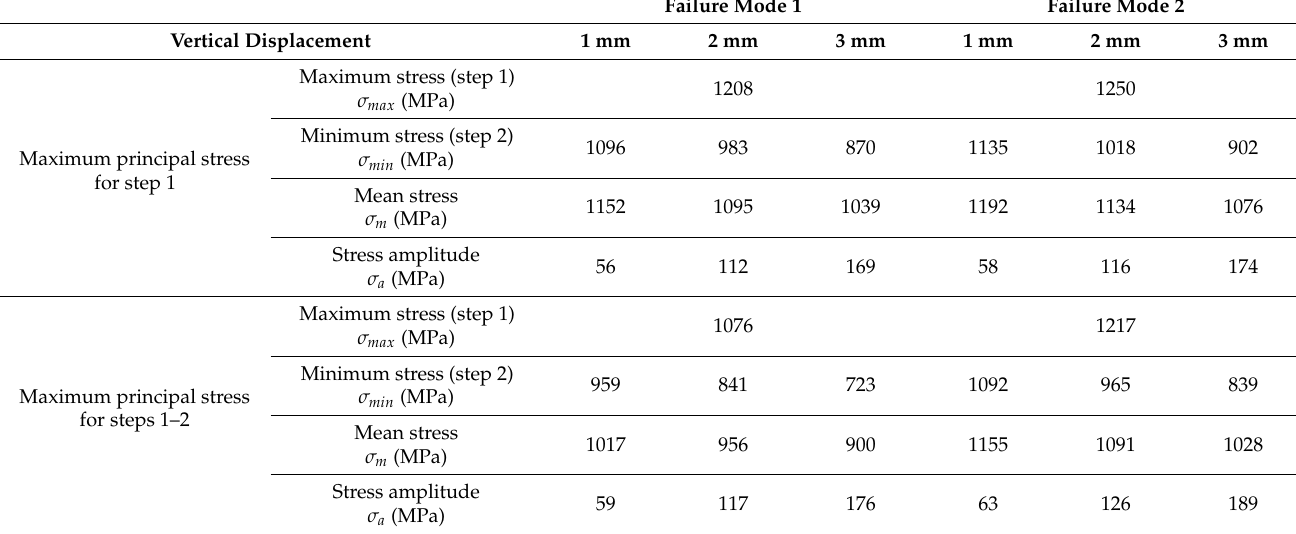
Table 3. Stress conditions for fatigue performance